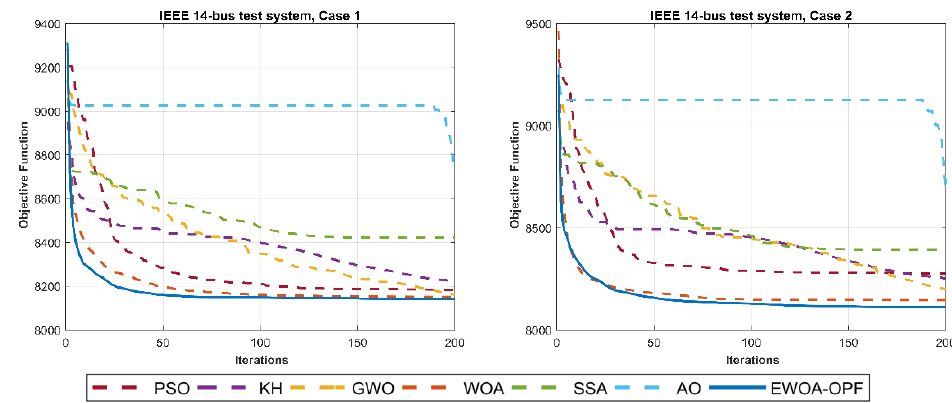
Figure 4. Curves for all test systems on Cases 1 and 2.